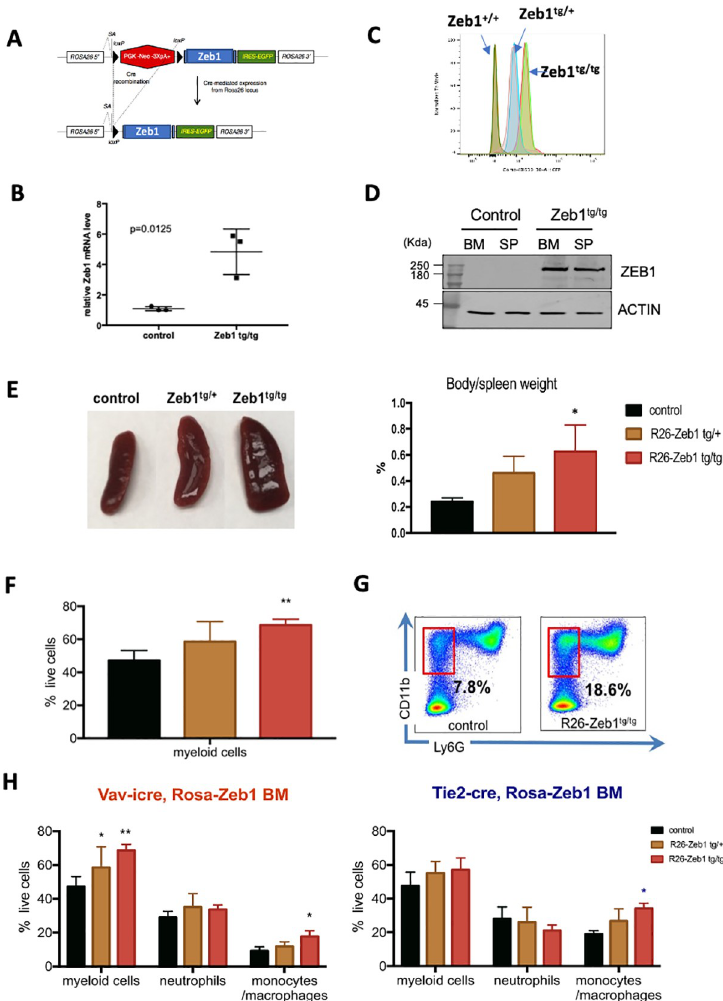
Fig 8. Zeb1 overexpression leads to extramedullary hematopoiesis/splenomegaly, enhanced myeloid cell development, and monocyte lineage skewing. (A) Schematic of conditional Rosa26- Zeb1 -IRES-EGFP-pA + transgenic locus (left). (B) Following Vav-iCre-mediated deletion of the lox P flanked transcriptional stop cassette Zeb1 expression is increased approximately 4.5-fold in transgenic BM HSPCs compared to controls ( N = three 5-month-old female mice/genotype, p = 0.0125; error bars indicate SD of the mean, Mann–Whitney test) along with (C) dosage-dependent EGFP expression in both heterozygous and homozygous Zeb1 transgenic HSPCs (Flow cytometry for EGFP). (D) Western blot confirmation of increased ZEB1 protein in the BM and spleen of Vav-iCre; Zeb1 tg/tg mice compared to Cre-negative control samples. (E) Increased spleen size/extramedullary hematopoiesis seen in Zeb1 tg/tg transgenic mice (left panel) showing roughly doubling in size compared to body weight (right panel). (F) Flow cytometric analysis showing increased myeloid cells in spleen (CD11b + , Gr1 + ). (G) Representative flow cytometry plot showing increased CD11b + , Lys6G - monocytes in the BM of Zeb1 tg/tg mice. (H) Increases in myeloid cells (CD11b + , Gr1 + ) with monocytic skewing/expansion was present in both Vav-iCre (left) and Tie2-Cre models (right). Data are represented as mean + SD from 3 biological replicates/genotype. � p < 0.05; �� p < 0.01, nonparametric t test. Raw data behind graphs and western blot in (D) are included in E of S1 and S2 Data, respectively. BM, bone marrow; HSPC, hematopoietic stem and progenitor cell; SP, spleen. KO alone versus 58 days median survival for Zeb1/2 DKO; Fig 9B and 9C ). Of note, we docu- mented significant effects of induced Cre activity alone on enhancing survival that is probably related to activation of DNA damage response pathways elicited by Cre binding to pseudo lox P sites in the genome [49,50]. Moreover, there were differences in the onset of lethality in